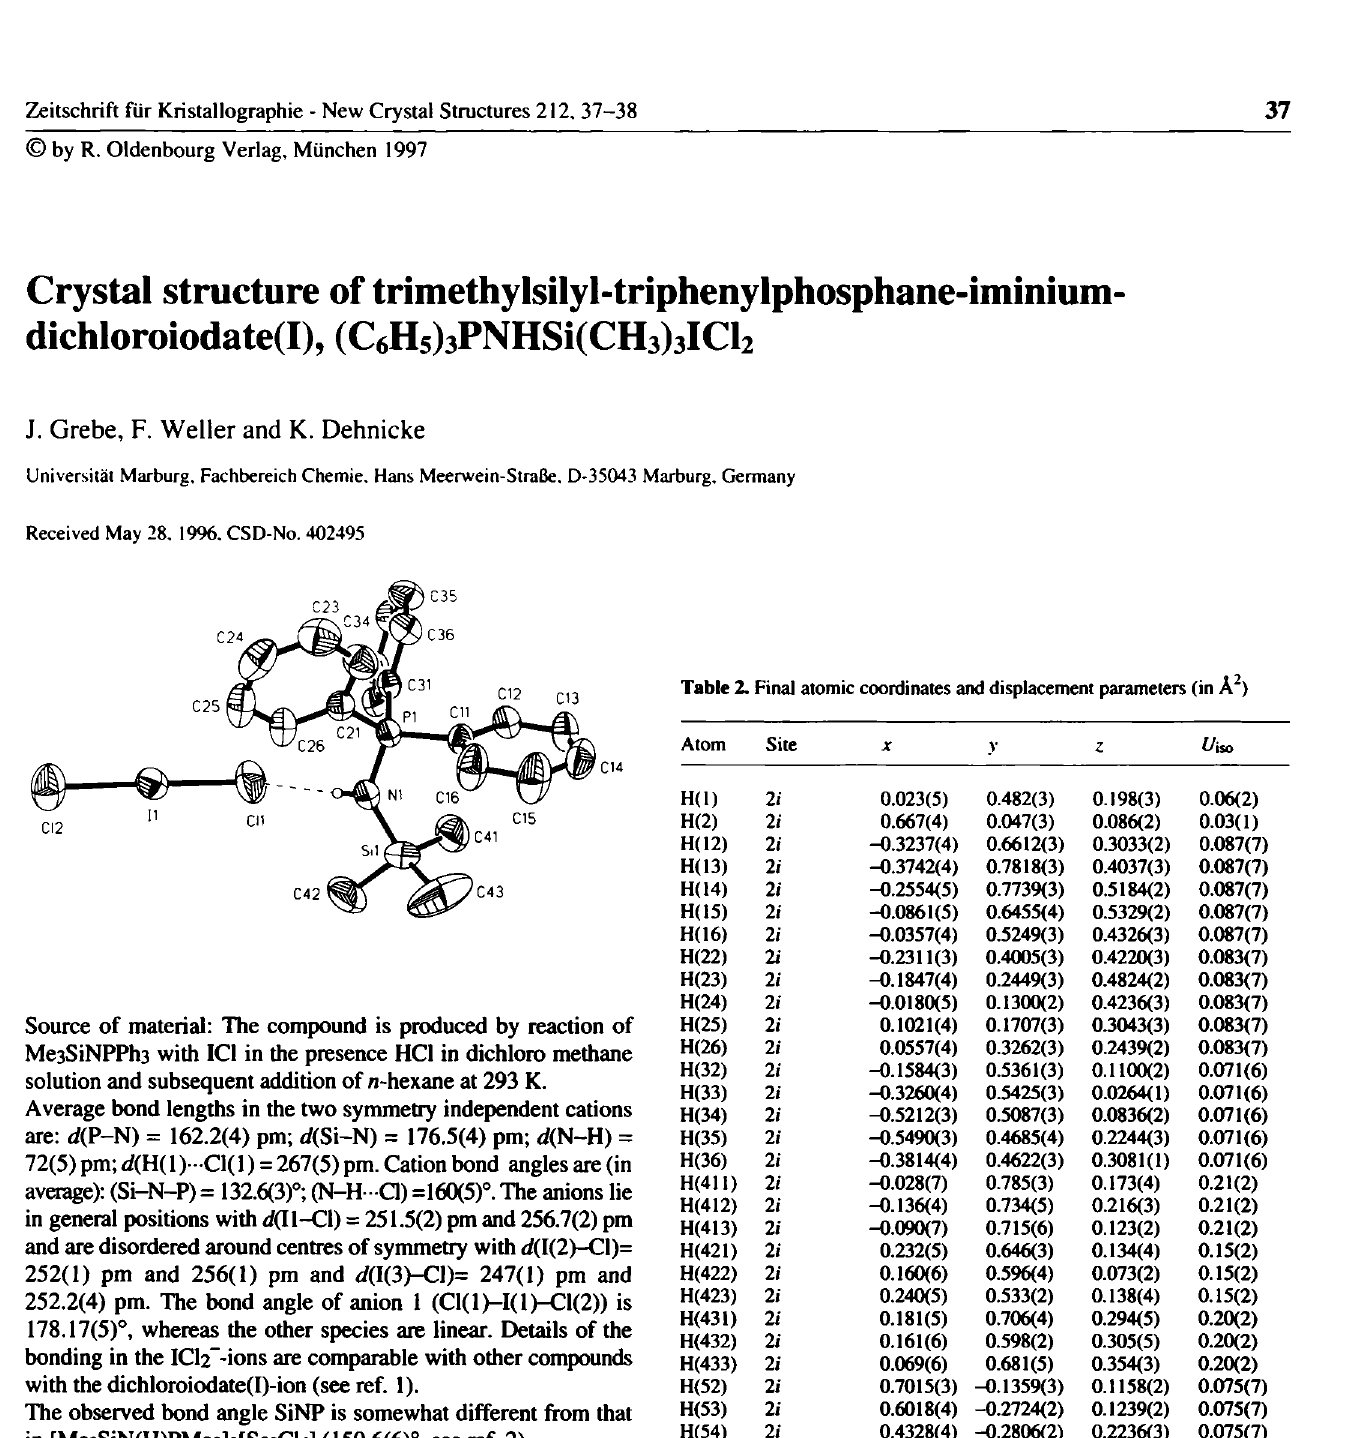
Table 1. Parameters used for the X-ray data collection Crystal: